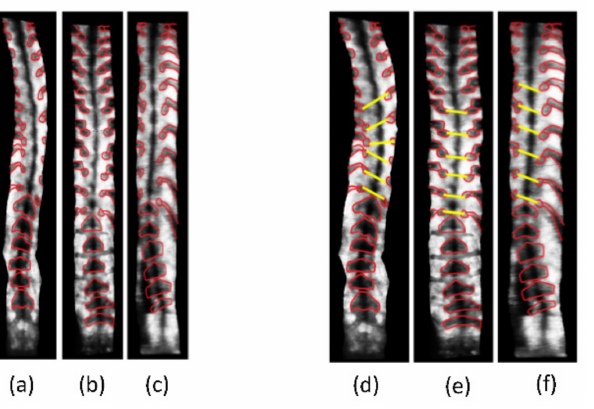
Figure 3. ( a – c ): Lateral bony features of different shapes, sizes, and locations. ( d – f ) Slopes between two adjacent bony features (thoracic) are